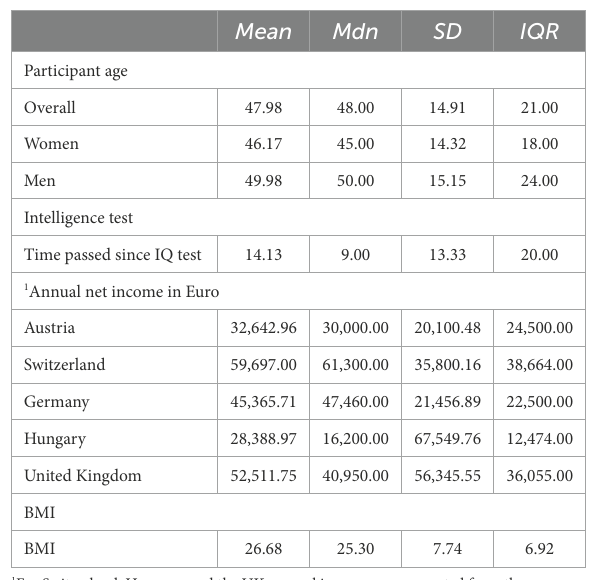
TABLE 1 Descriptive statistics for the current